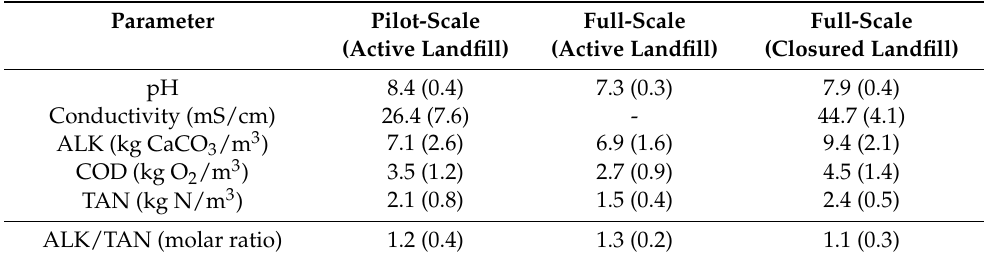
Table 1. Main characteristics of the landfill leachate treated in the pilot- and full-scale implementations 1